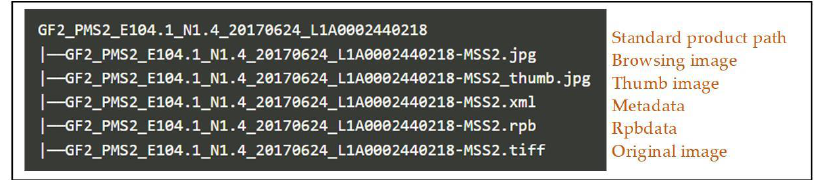
Figure 2. Structure of cloud-amount calculation based on a composite neural network.